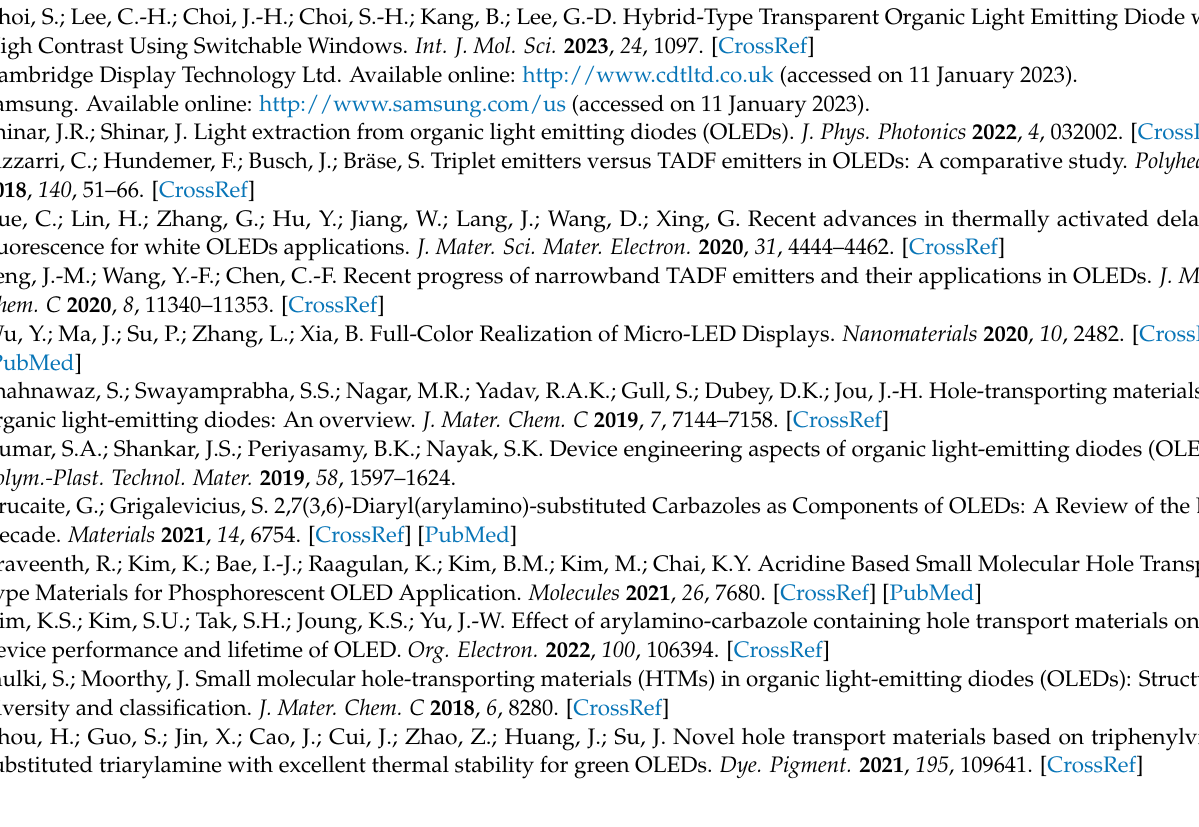
curve of the material 5 ; Figure S5. Thermo-gravimetric analysis curve of the material 6 ; Figure S6. DSC curves of material 6 ; Figure S7. Mass spectrum of material 4 ; Figure S8. Mass spectrum of material 5 ; Figure S9. Mass spectrum of material 6 ; Figure S10. FT-IR spectrum of material 4 ; Figure S11. FT-IR spectrum of material 5 ; Figure S12. FT-IR spectrum of material 6 ; Figure S13. 1H NMR of material 4 ; Figure S14. 1H NMR of material 5 ; Figure S15. 1H NMR of material 5 ; Figure S16. 13C NMR of material 4 ; Figure S17. 13C NMR of material 5 ; Figure S18. 13C NMR of material 5